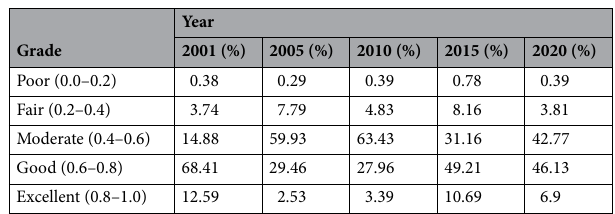
Table 4. Percentage of RSEI grade in northern Anhui from 2001 to 2020.